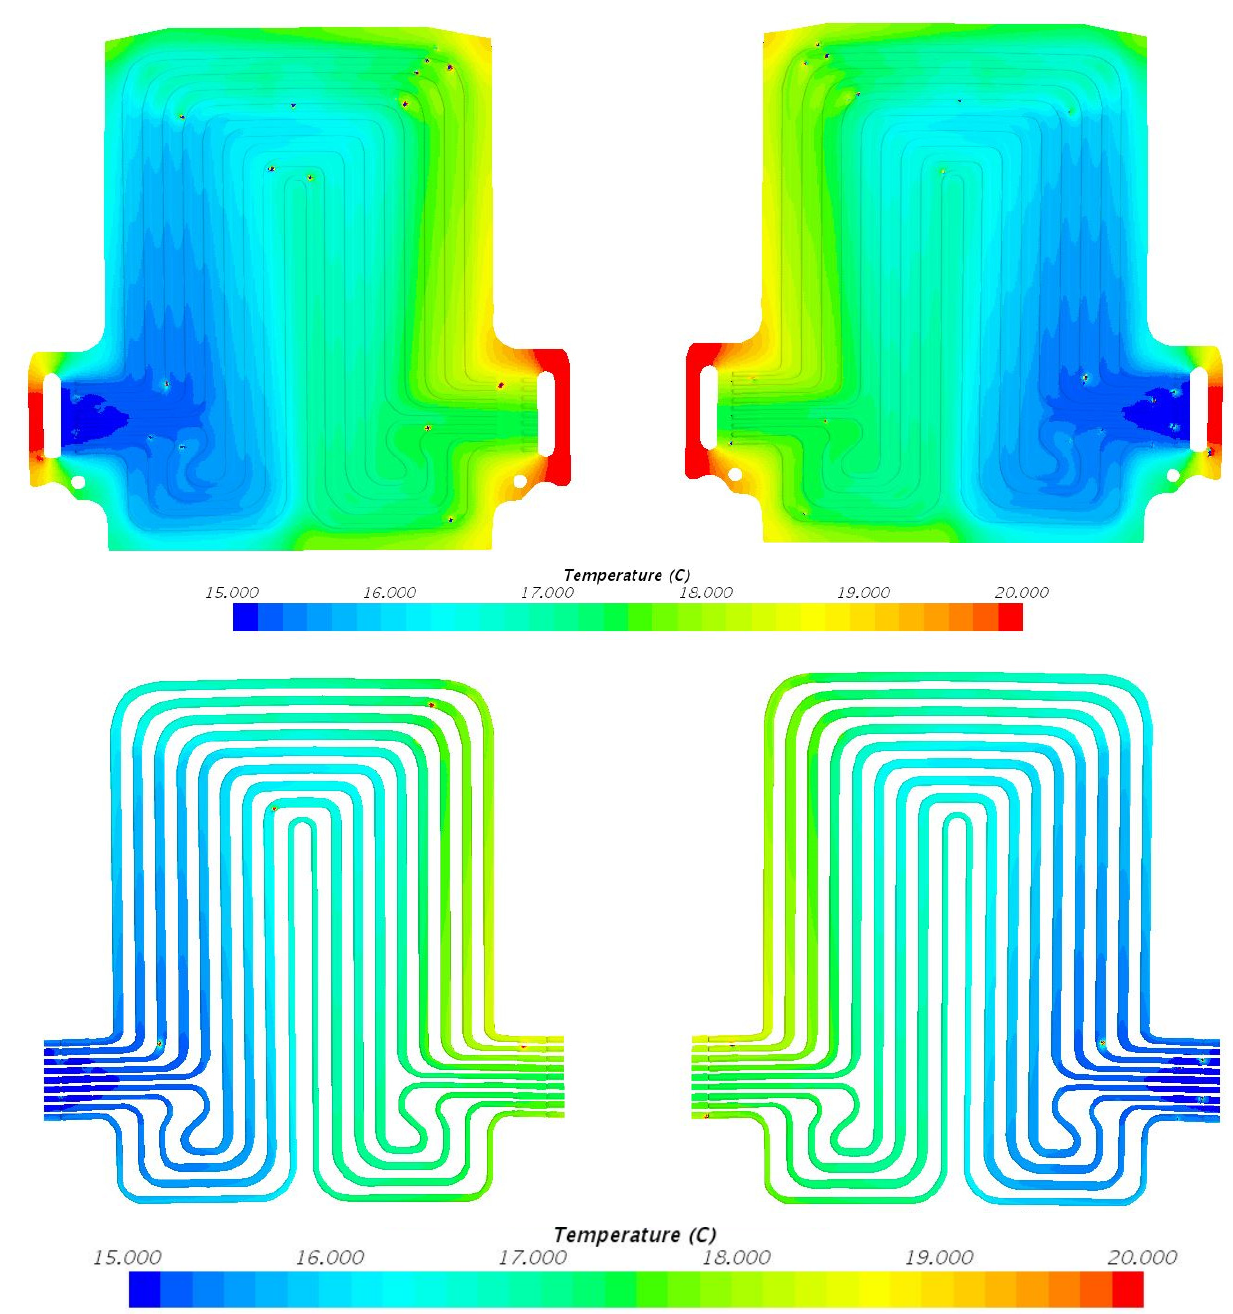
Figure 12. Temperature field at 40 A discharge current and 15 °C coolant inlet temperature, with heat flux at position 1 = 1029.7 W/m 2 , position 2 = 1509.9 W/m 2 , and position 3 = 331.7 W/m 2